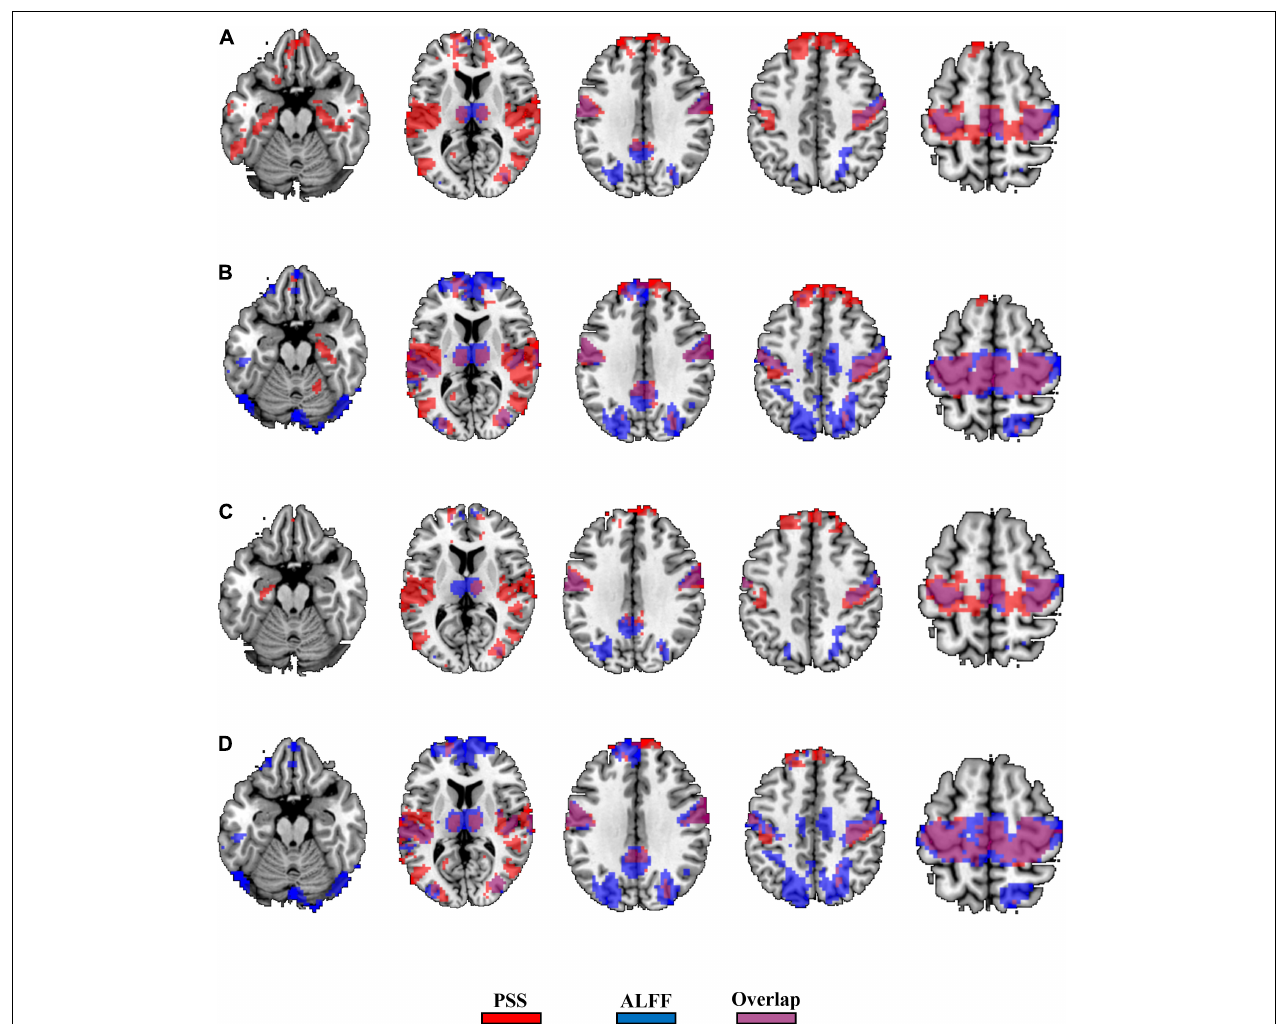
FIGURE 11 | Binary spatial overlap between the EC–EO differences using PSS and ALFF (0.01–0.25 Hz). Panel (A) shows the spatial overlap of the EC–EO difference using the PSS (linear coefficient b) and ALFF (0.01–0.25 Hz) with group Z-transformation. Panel (B) shows the spatial overlap of the EC–EO difference using the linear coefficient b and ALFF (0.01–0.25 Hz) with individual Z-transformation. Panel (C) shows the spatial overlap of the EC–EO difference using the PSS (power-law slope b’) and ALFF (0.01–0.25 Hz) with group Z-transformation. Panel (D) shows the spatial overlap of the EC–EO difference using the PSS (power-law slope b’) and ALFF (0.01–0.25 Hz) with individual